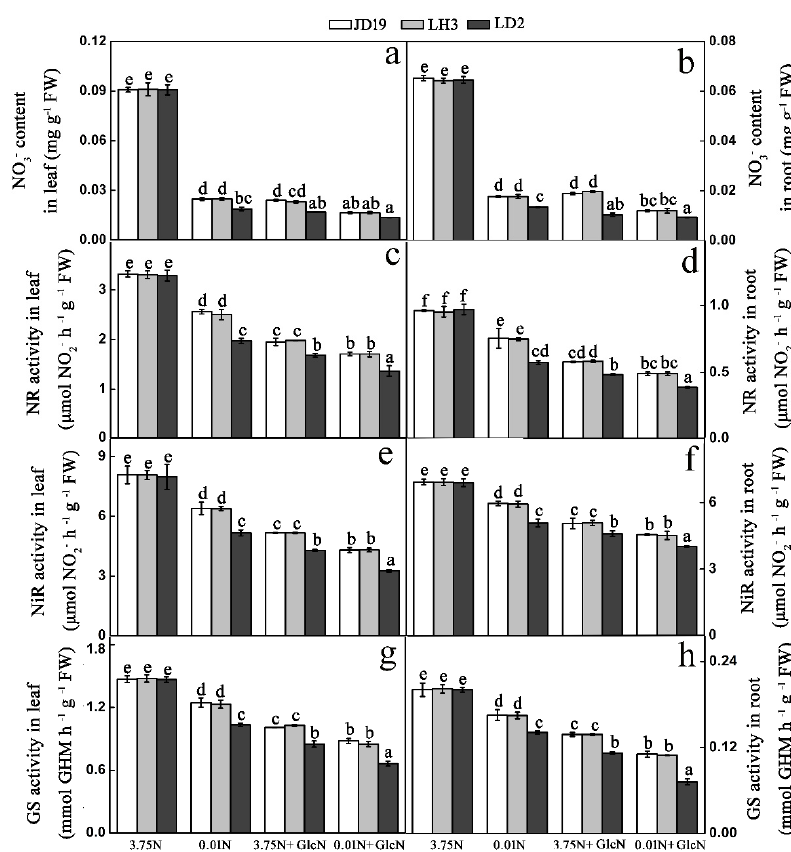
Figure 6. Effects of GlcN on NO 3 − content and NR, NiR, and GS activity in three soybean cultivars under low-N stress. ( a ) NO 3 − content, ( c ) NR activity, ( e ) NiR activity, ( g ) GS activity in leaves, ( b ) NO 3 − content, ( d ) NR activity, ( f ) NiR activity, ( h ) GS activity in roots ( b , d,f , h ). 10 mM GlcN was added into 1/4 Hoagland medium (pH 6.0) with 3.75 N or 0.01 N for 48 h. Data are means ± SE ( n = 3, p < 0.05). The letters show significant differences under N conditions.